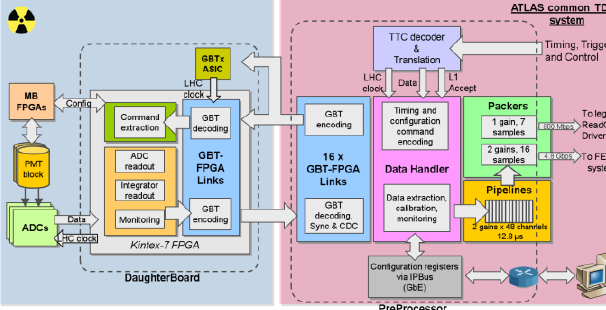
Fig. 6. Block diagram describing the main blocks used for the implementation of the clock and readout architecture for the HL-LHC. The downlink communication uses the GBT protocol with Forward Error Correction (FEC), where the FPGA transceivers are configured to operate with fixed and deterministic latency at a data rate of 4.8